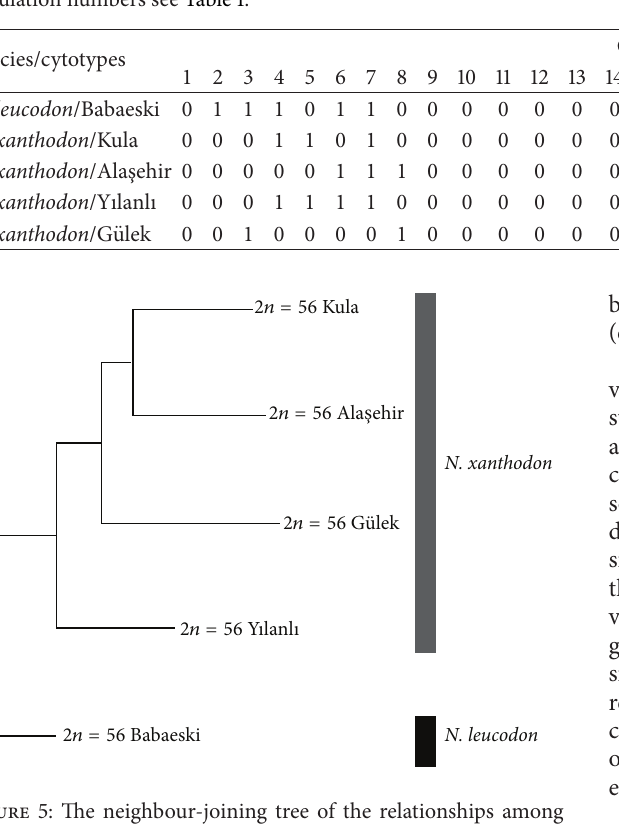
Table 3: The character distribution of the AgNOR sites on individual chromosome pairs according to the presence (1) and absence (0). For population numbers see Table 1.